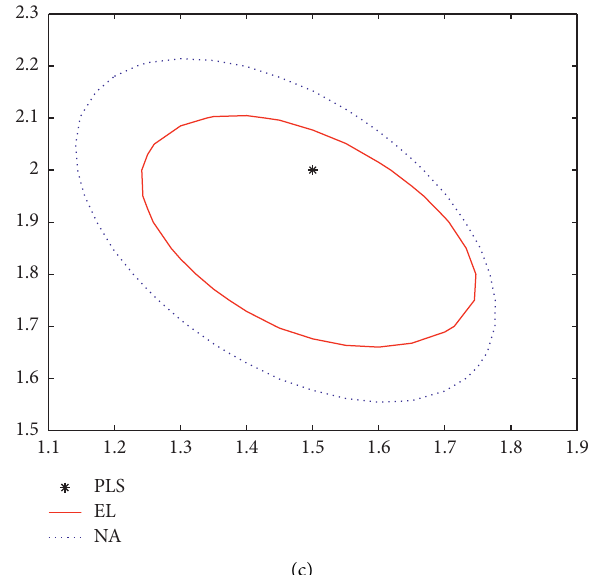
Figure 2: 95% confidence regions for ( β